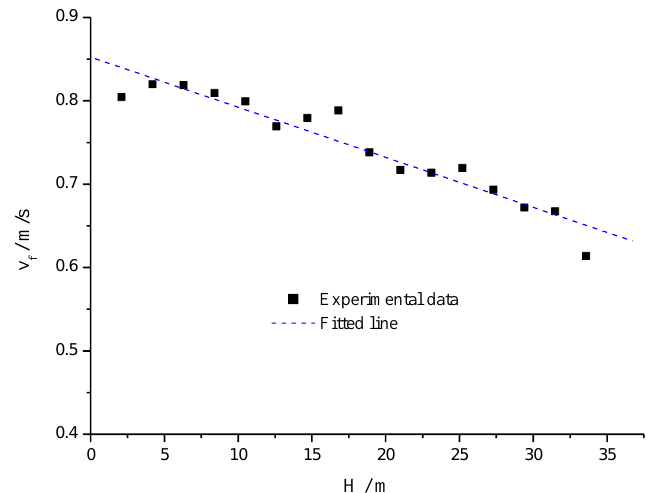
Figure 13. Variation in the mean ascent speed of females with vertical height.